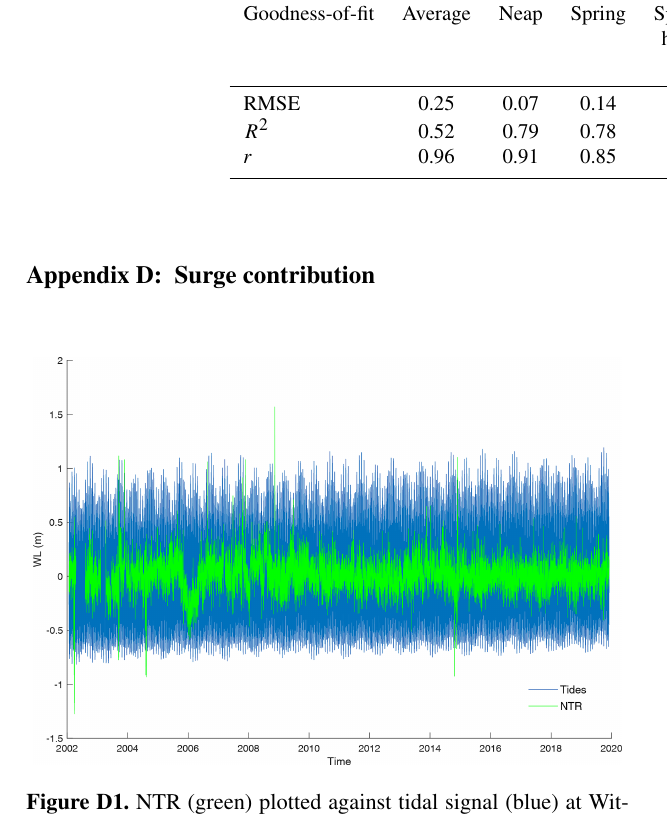
Figure D1. NTR (green) plotted against tidal signal (blue) at Wit-